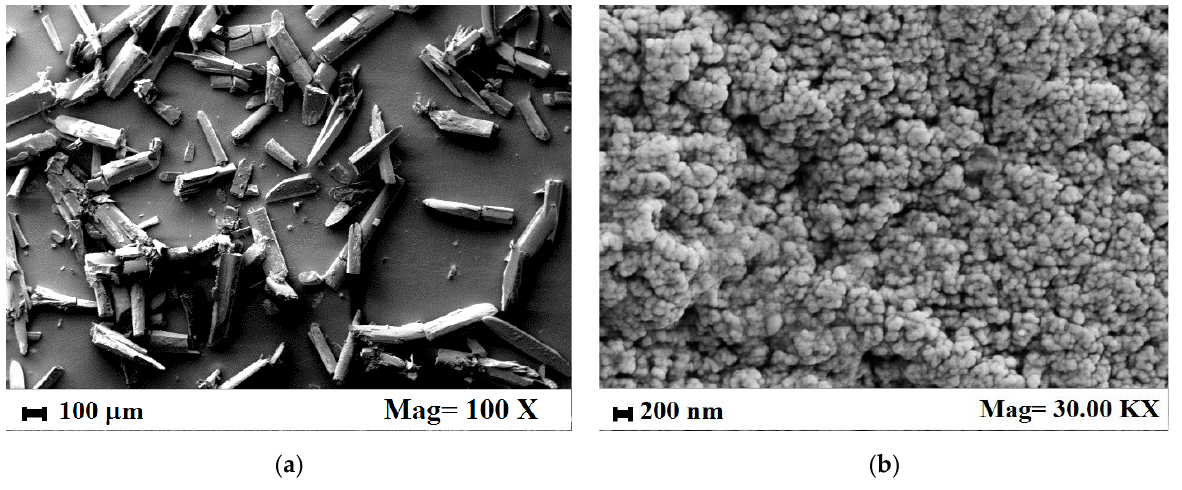
Figure 7. SEM images of ( a ) untreated curcumin powder and ( b ) curcumin nanoparticles collected after DLS dissolution analysis.